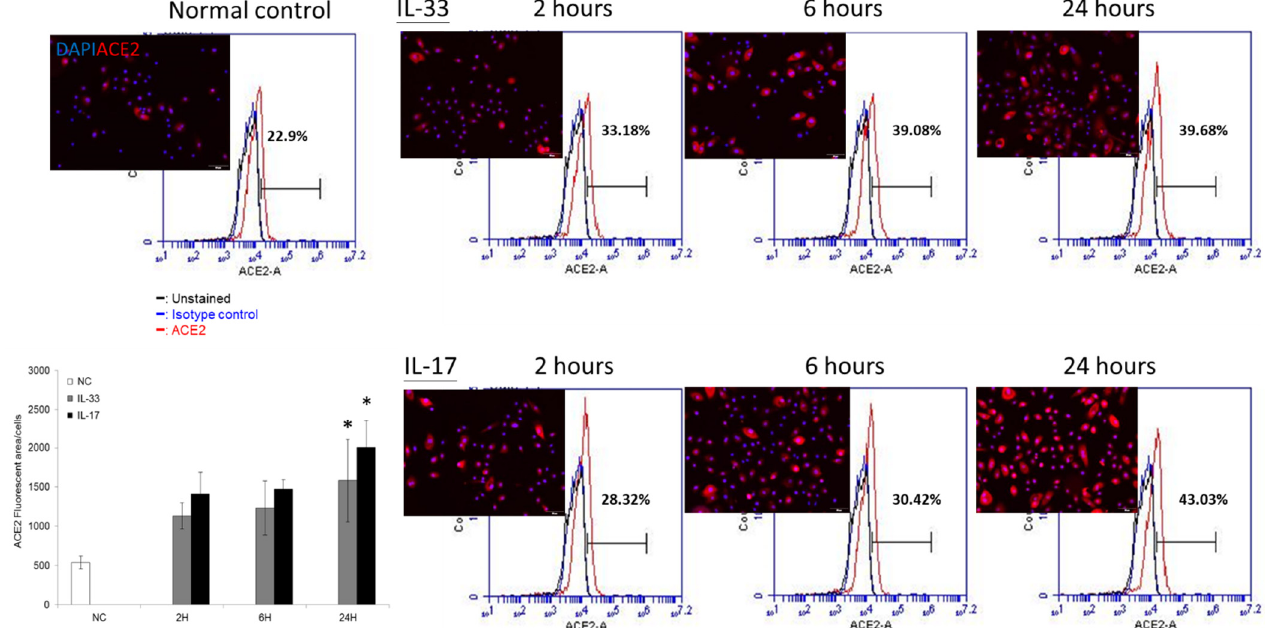
Figure 3. ACE2 is constitutively expressed in the cultured keratinocytes. We performed flow cytom- etry and immunofluorescence examinations for evaluating the ACE2 expression. Keratinocytes were treated with IL-33 and IL-17 at 10 ng/mL for 2, 6, and 24 h, respectively. The ACE2 protein expression under IL-33 (upper row) or IL-17 stimulation (lower row) was measured using flow cy- tometry and immunofluorescence examinations (representative data from three repeated experi- ments). The bar graph represents the quantification of the intensity of the ACE2 expression through immunofluorescence examinations. * indicates p < 0.05 compared with baseline ACE2.